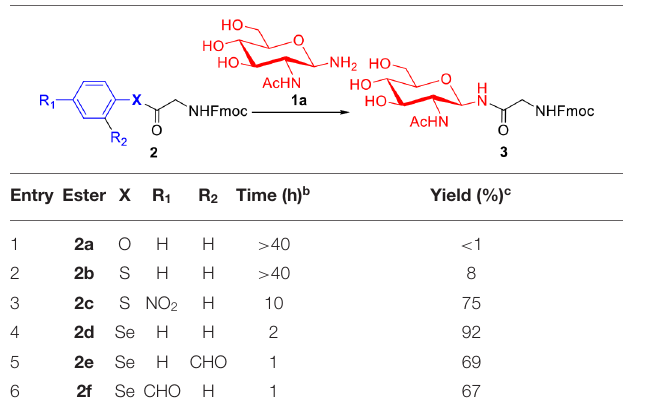
p -nitrophenyl thioester has been successfully utilized to prepare N -linked glycopeptide in our lab (Du et al.,